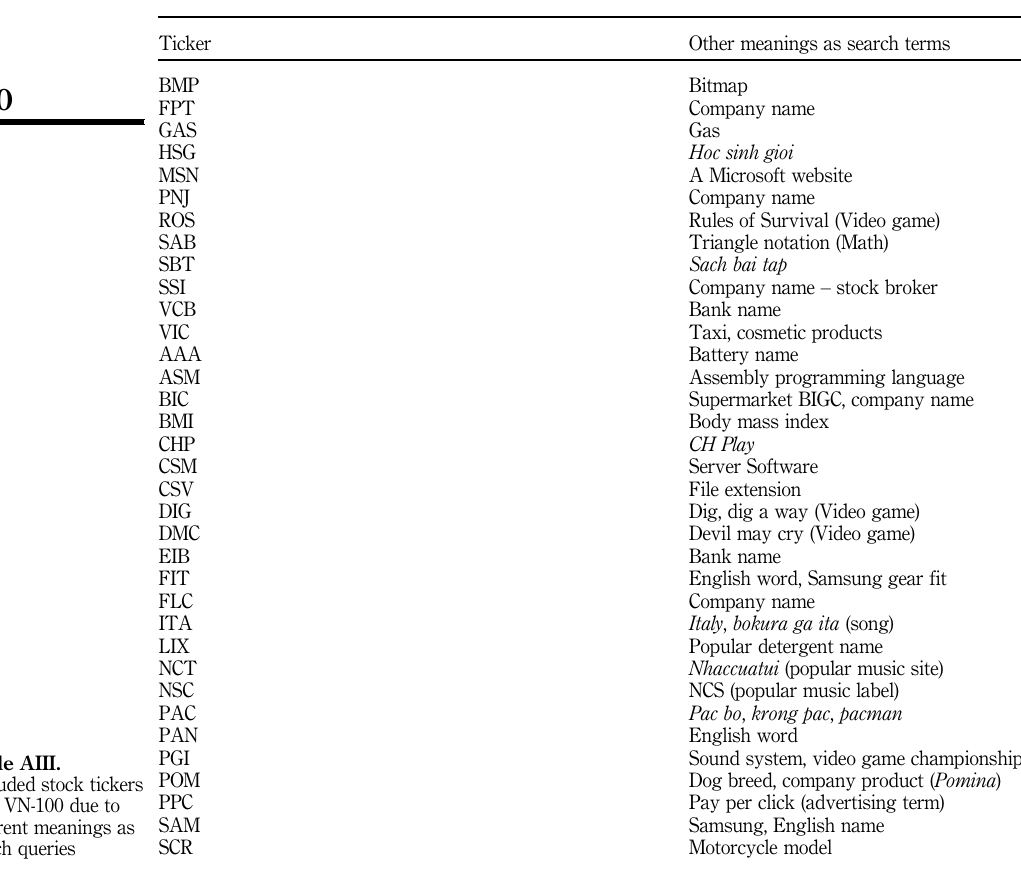
Table AIII. Excluded stock tickers from VN-100 due to different meanings as search